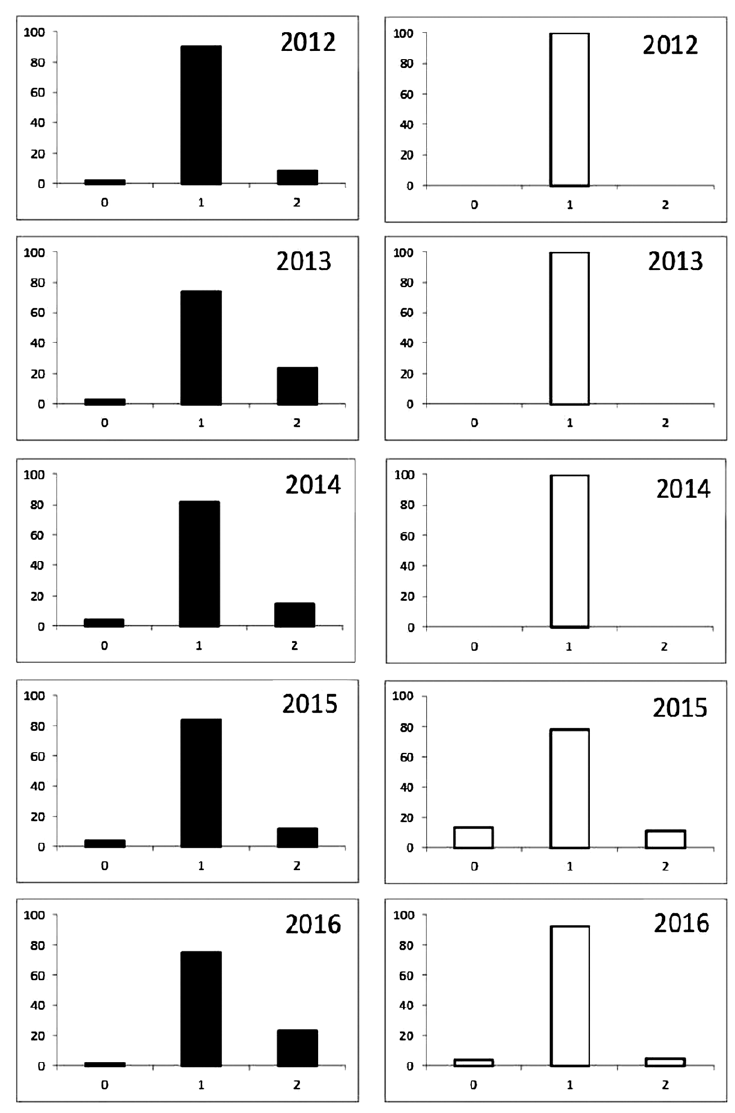
Fig. 4. – Anchovy age distribution (percentage) by year group (years) for the time series in GSA06 on the left side (in black) and GSA01 on the right side (in white).